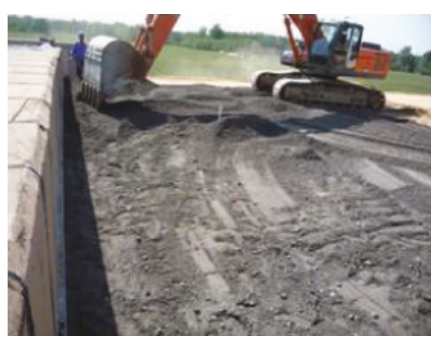
Figure 18: Leveling.